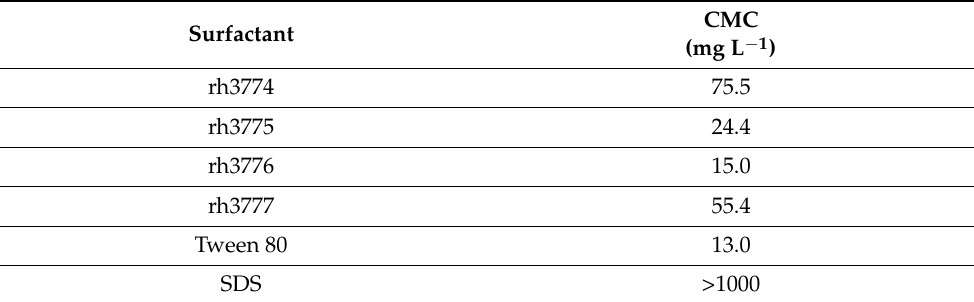
Table 2. Critical micelle concentrations (CMC) of tested rhamnolipid mixtures and synthetic surfactants.